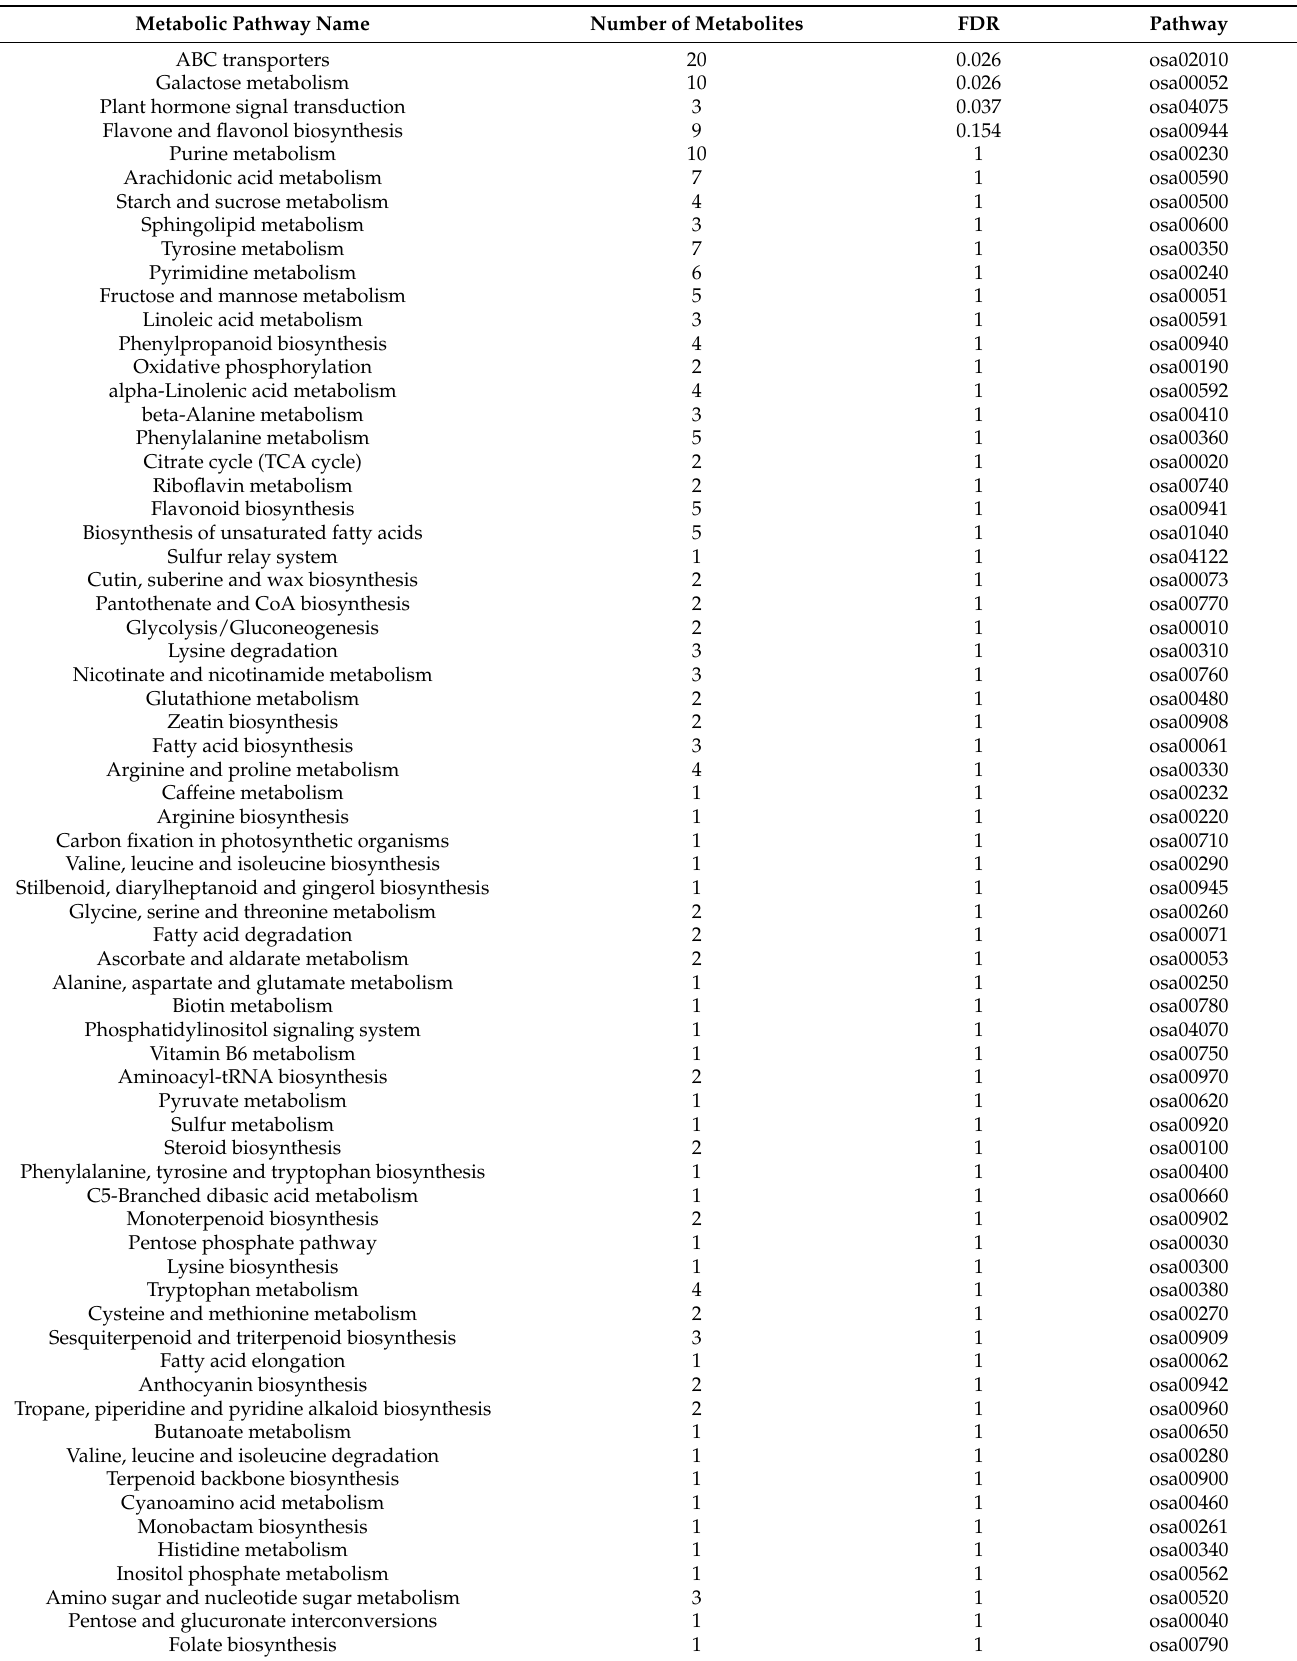
Table 2. KEGG enrichment pathway of differential